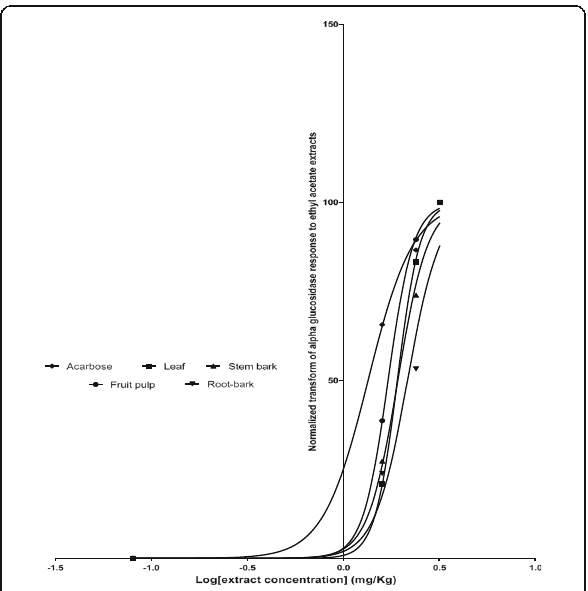
Fig. 11 Dose-response curve of α -glucosidase inhibition by ethyl acetate extract of Annona muricata fruit-pulp, leaf, stem-bark, root- bark and acarbose (reference standard)